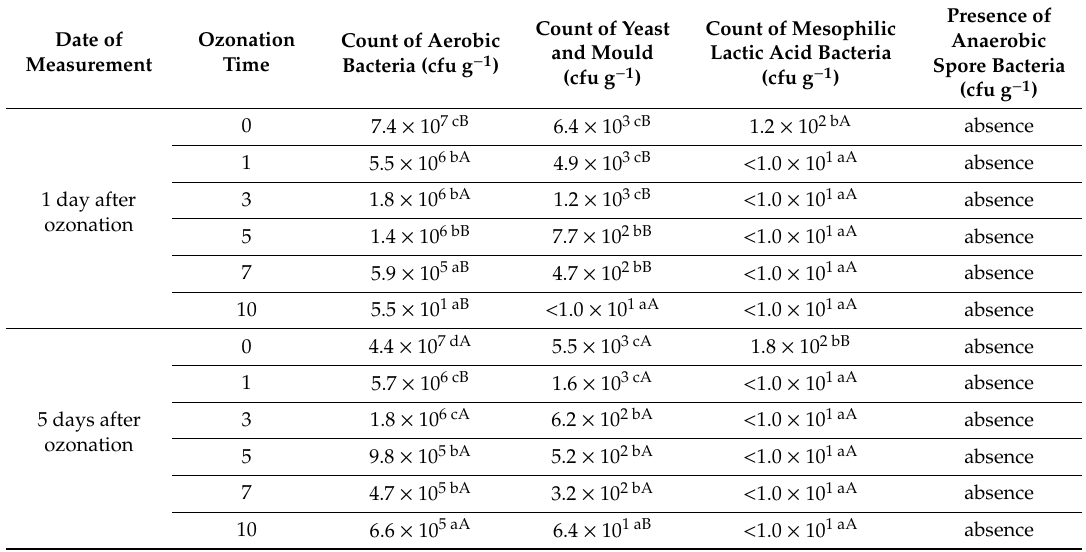
Table 3. Microbial stress in Origanum majorana L. plants on the first and fifth days after ozonation relative to the duration of the treatment (n =